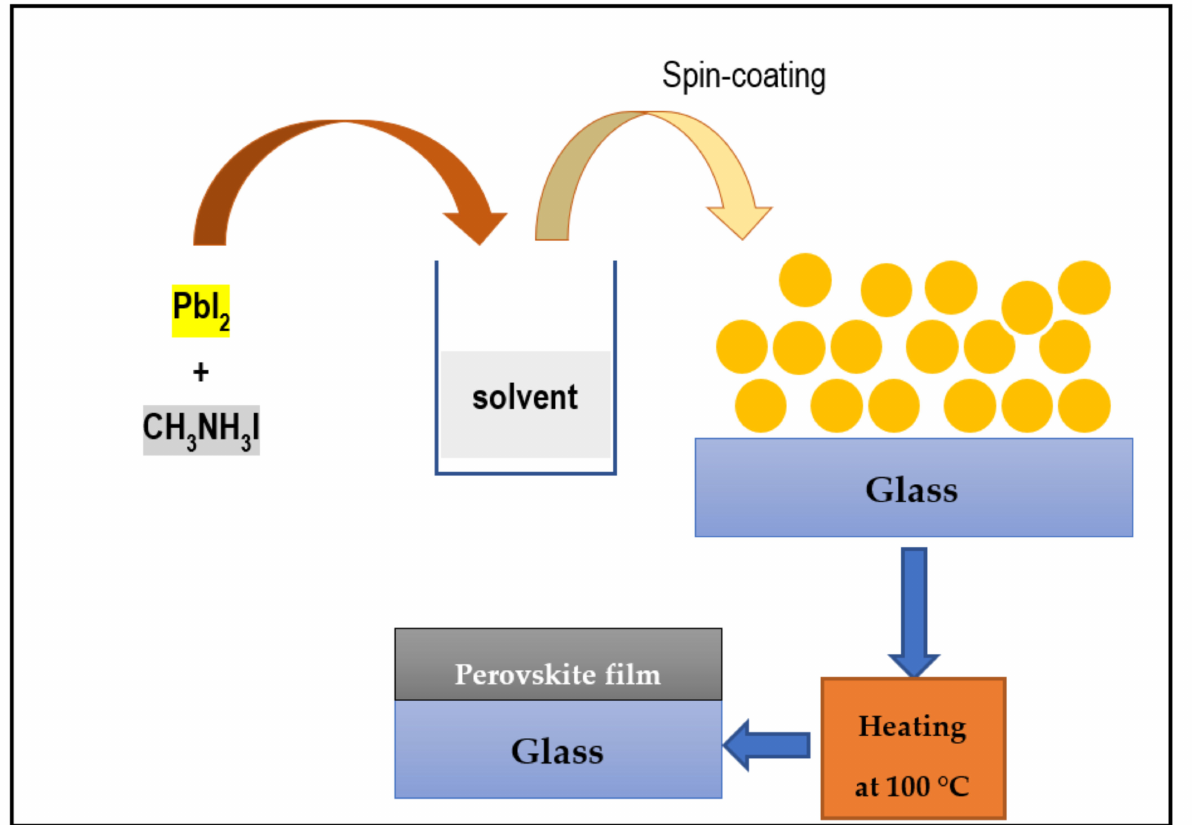
Figure 1. Schematic diagram of the deposition process used to prepare the perovskite film in this